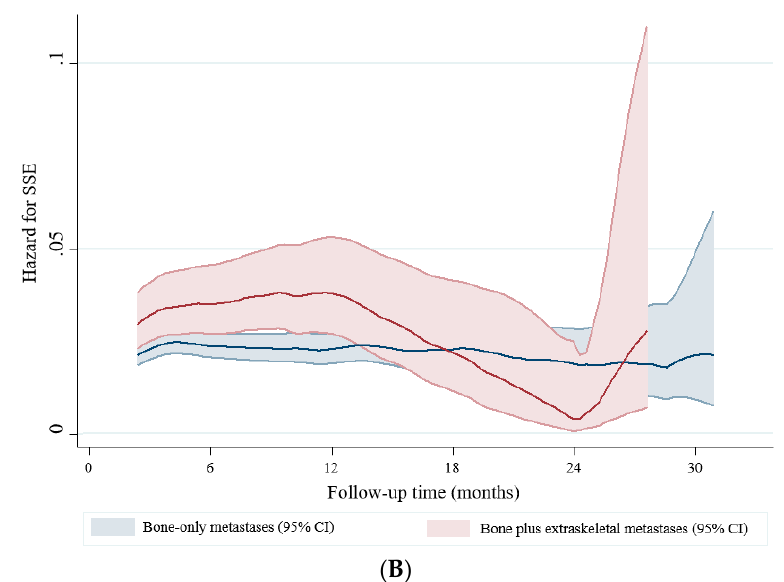
Figure 3. ( A ) Time-to-first on-study SSE; ( B ) Hazard for first on-study SSE. Hazards model.BESM, Bone and extraskeletal metastases; BOM, bone-only metastases; CI, confidence interval; ESD, extraskeletal disease; HR, hazard ratio; IQR, interquartile range; NR, not reached; pts, patients; SSE, symptomatic skeletal event. Table 4. Risk for development of first on-treatment SSE. Characteristic